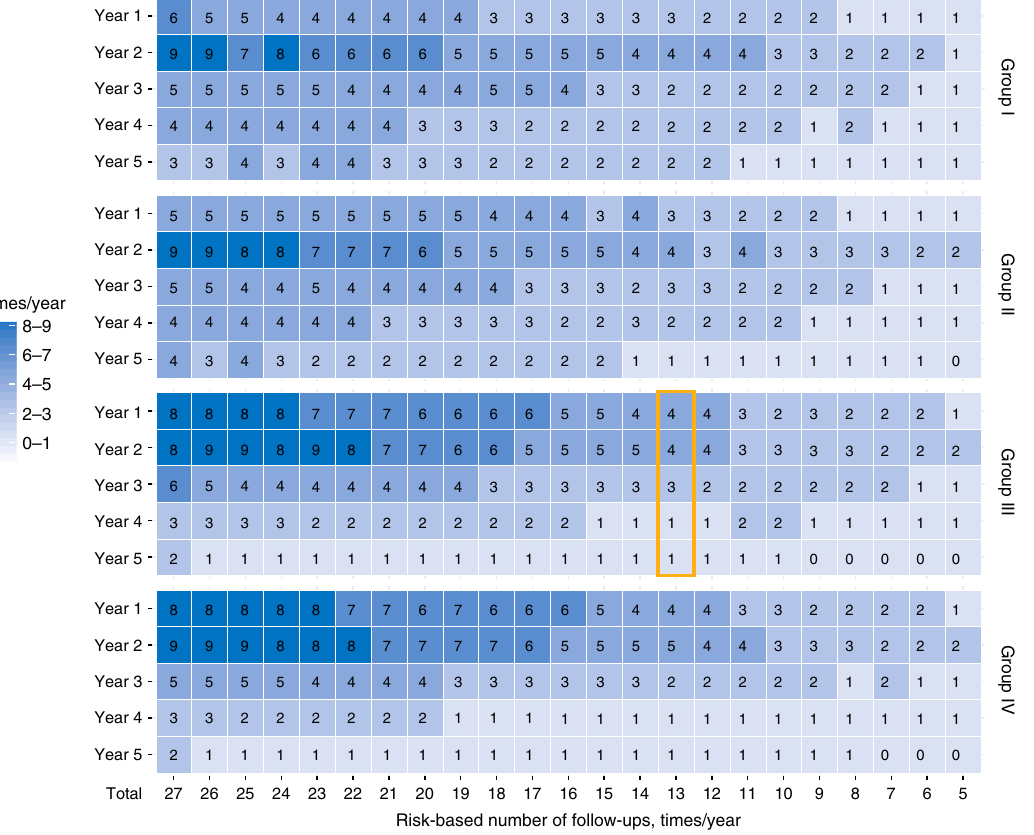
Fig. 3 The risk-based surveillance arrangements varied 27 to 5 visits for early detection of disease failure. The follow-up arrangements for a total of 13 visits for group III are highlighted in the orange